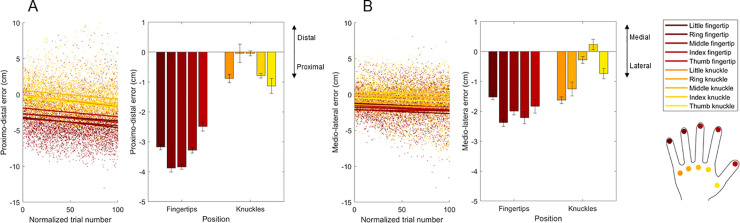
Slopes (left panels, scatterplots) obtained from the Linear Mixed-Effects Models describing the effect of normalized trial number on the proximo-distal (A) and medio-lateral (B) localization errors are represented for each hand landmark. Estimated marginal means (right panels, bar plots) obtained from the same models are represented for the proximo-distal (A) and medio-lateral (B) localization errors. Error bars indicate standard errors of the mean.